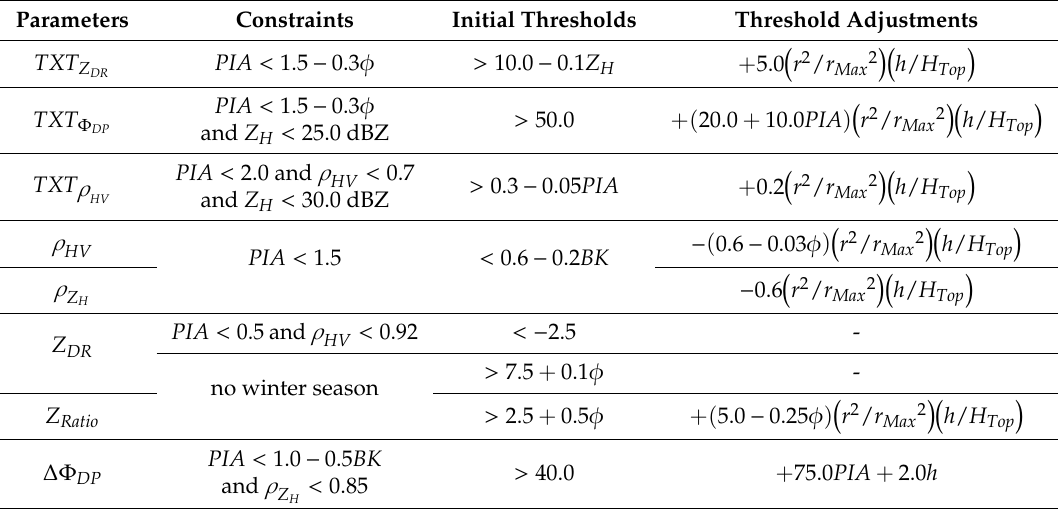
Table 3. Feature parameters and classification conditions for non-precipitation